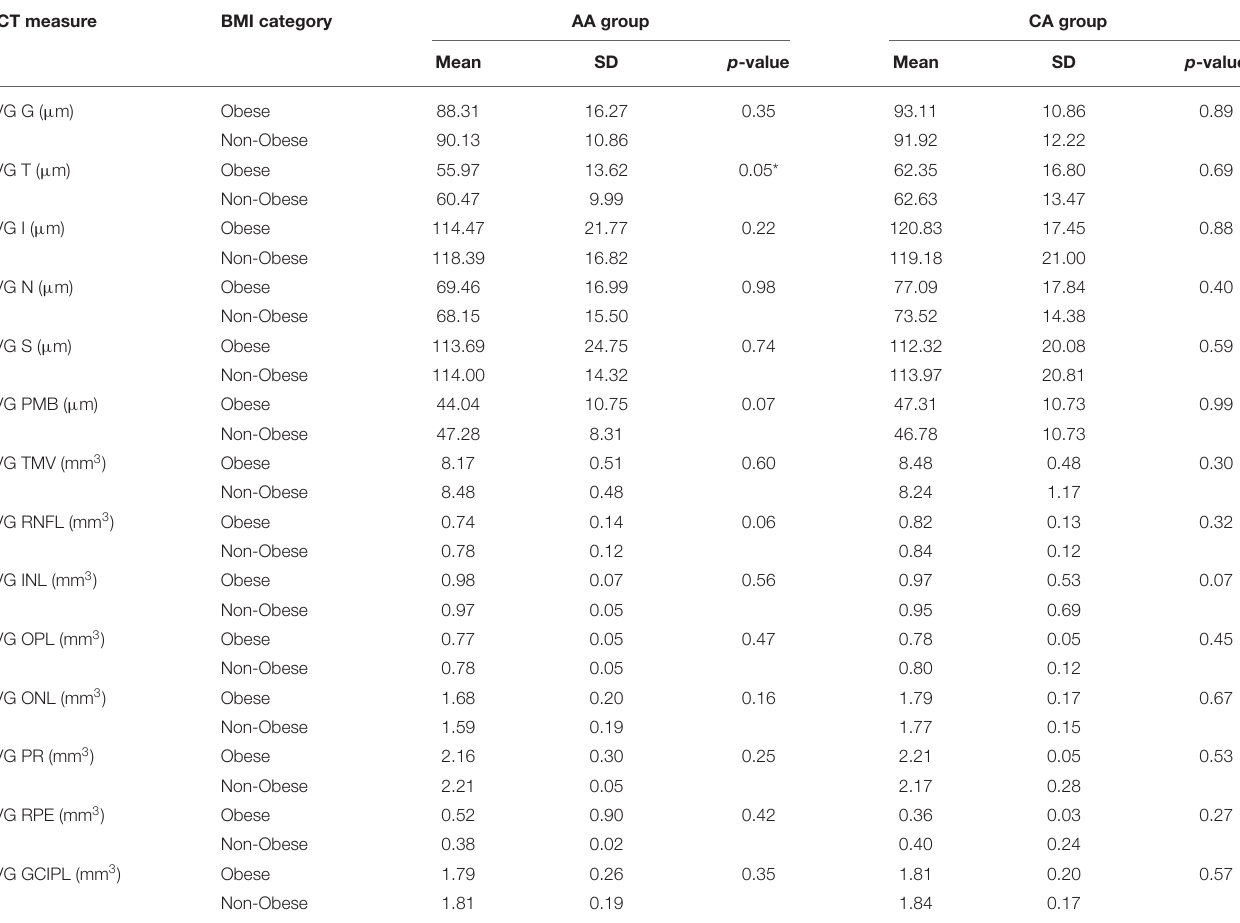
TABLE 5 | Intra-racial